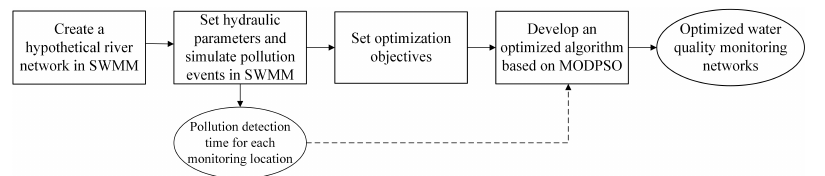
Figure 1. Main process of our algorithm.